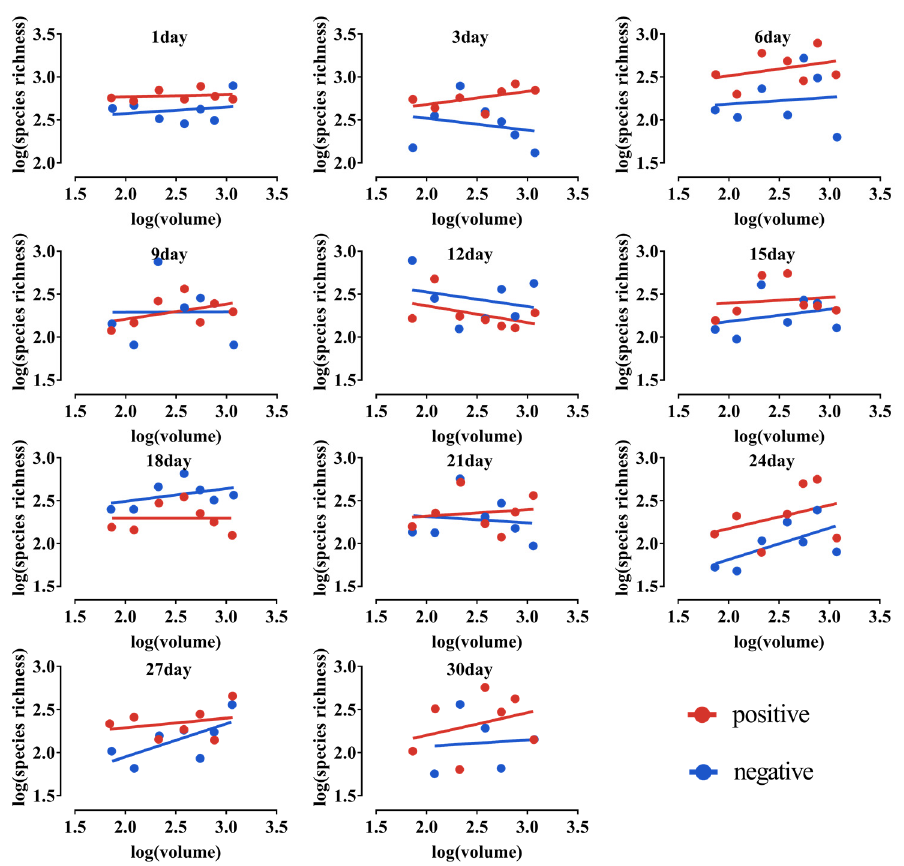
Figure 8. SAR curves for the microcosm system over 30 days. Positive is the treatment where dry matter mass is positively related to volume; negative is the treatment where dry matter is negatively related to volume. The solid line is the regression line. Table 1. Statistical results of SAR curve fitting.